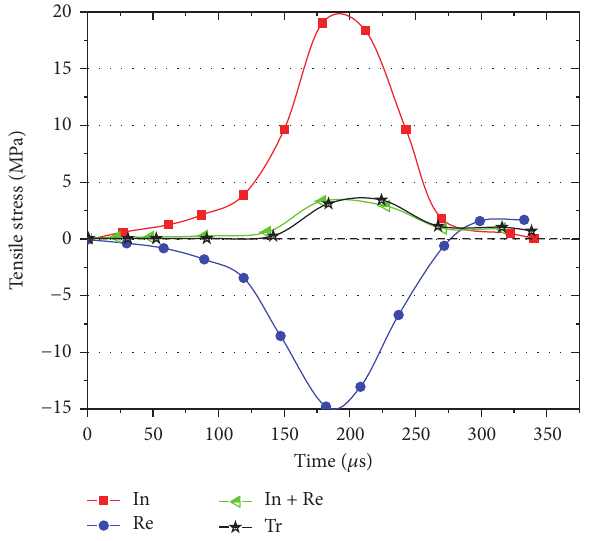
Figure 10: Dynamic force balance of Brazilian samples ( 𝑉 = 3.3 m/s) in the SHPB